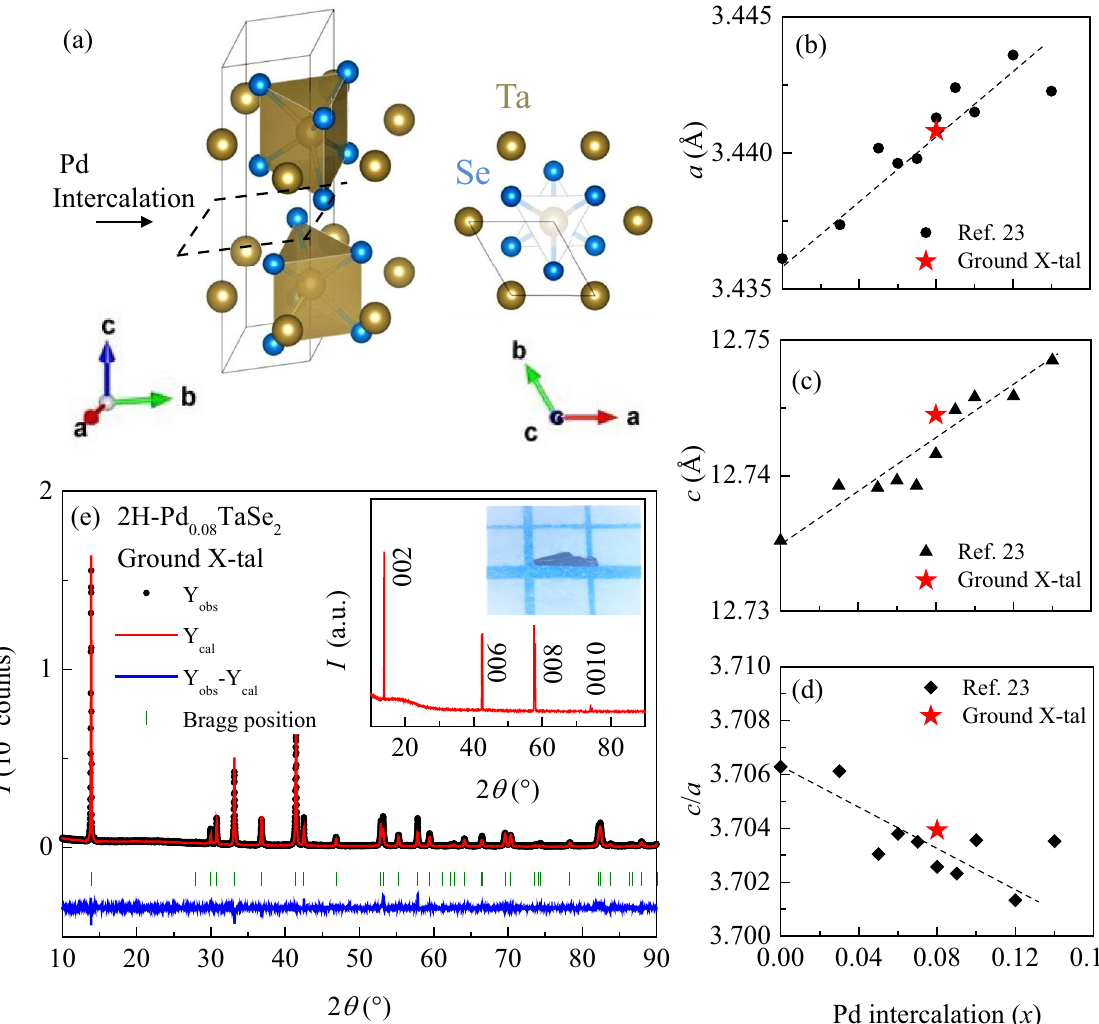
Figure 1. ( a ) The 2H-structure of TaSe 2 shows that a pair of two 1H-TaSe 2 layers form one unit cell. ( b ) and ( c ) show the evolution of lattice parameters a and c , respectively, with Pd intercalation ratio ( x ), which are replotted from the results by Bhoi et al. 23 . The corresponding values obtained from the refinement of the XRD data on the ground Pd 0.08 TaSe 2 crystals are also plotted as red stars. ( d ) The calculated c / a ratio based on the data in ( b ) and ( c ). The black dashed lines in ( b )–( c ) refer to the linear guide to eyes. The inset of ( e ) shows an XRD pattern measured on the ab -plane of a 2H-Pd 0.08 TaSe 2 single crystal and a photo of the crystal piece ( mm 2 ) lying on a graph paper with one unit of 1 mm. ( e ) An XRD pattern of the ground crystal (black dot), the Rietveld refinement result (red line) with R wp =22.1 and χ 2 =4.06, and their subtracted pattern (blue line) along with the expected XRD peak positions (green